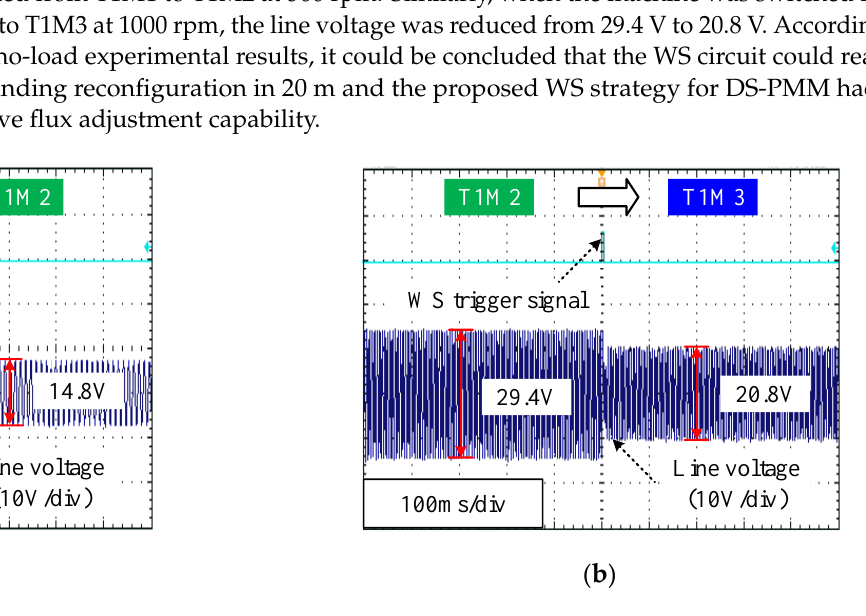
Figure 10. Measured torque–speed curves of the DS-PMM prototype in the three operating modes with the type I WS circuit.